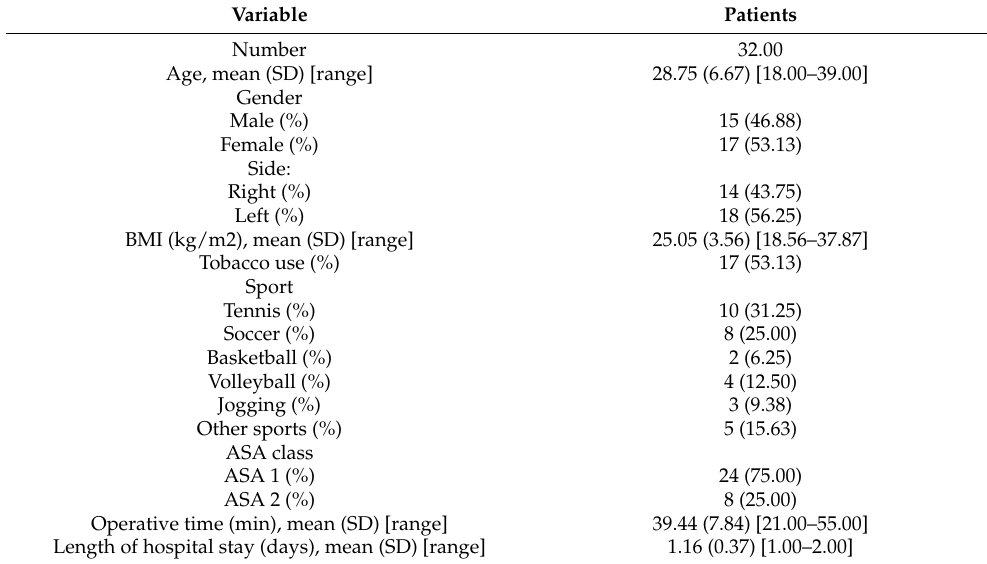
Table 1. Preoperative and perioperative